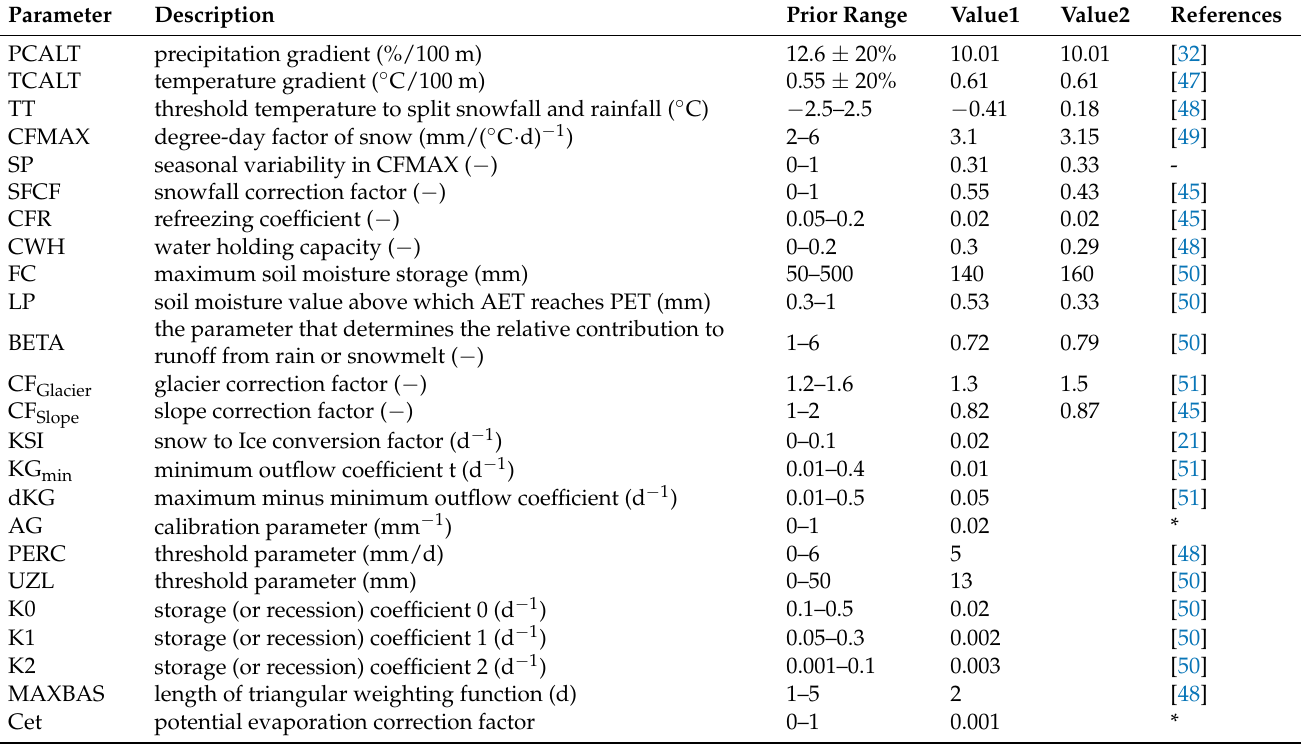
Table 2. Optimized parameter set of the HBV